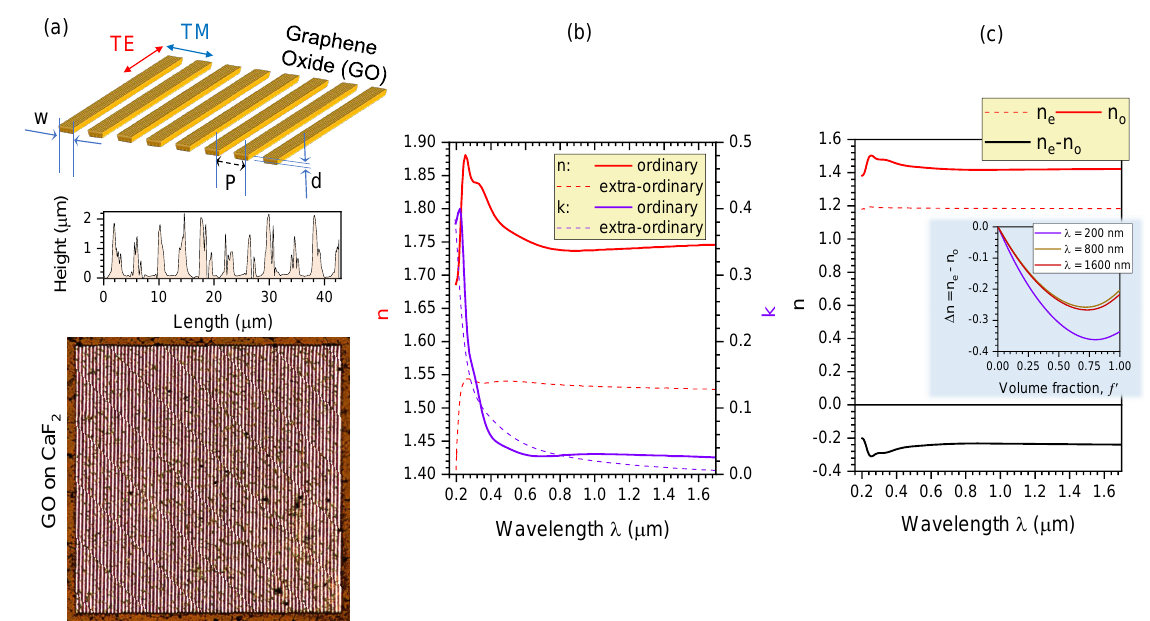
Figure 3. ( a ) Schematics of the GO polariser. Optical microscopy image (transmission mode) of the fabricated GO polariser 300 × 300 µ m 2 (over the footprint of MLA) and an optical profile trace (single pixel) across the grating. ( b , c ) Birefringence modelling of the GO grating; see text for dis- cussion. ( b ) The ordinary and extra-ordinary optical constants of a thick drop-cast GO layer deter- mined by a multiple-location analysis of spatially resolved data obtained by spectroscopic ellipsome- try [41]. ( c ) The ordinary and extra-ordinary complex refractive indices, as well as the birefringence ∆ n = n e − n o of the GO grating structure, calculated by substituting the ordinary, extra-ordinary and complex refractive indices ˜ n = n + i κ of GO layer from ( b ) into the standard form-birefringence formulae given by Equation (4). The inset shows ∆ n vs. f (cid:48) dependence at different wavelengths λ ; the volume fraction f (cid:48) = 1 corresponds to a homogeneous GO